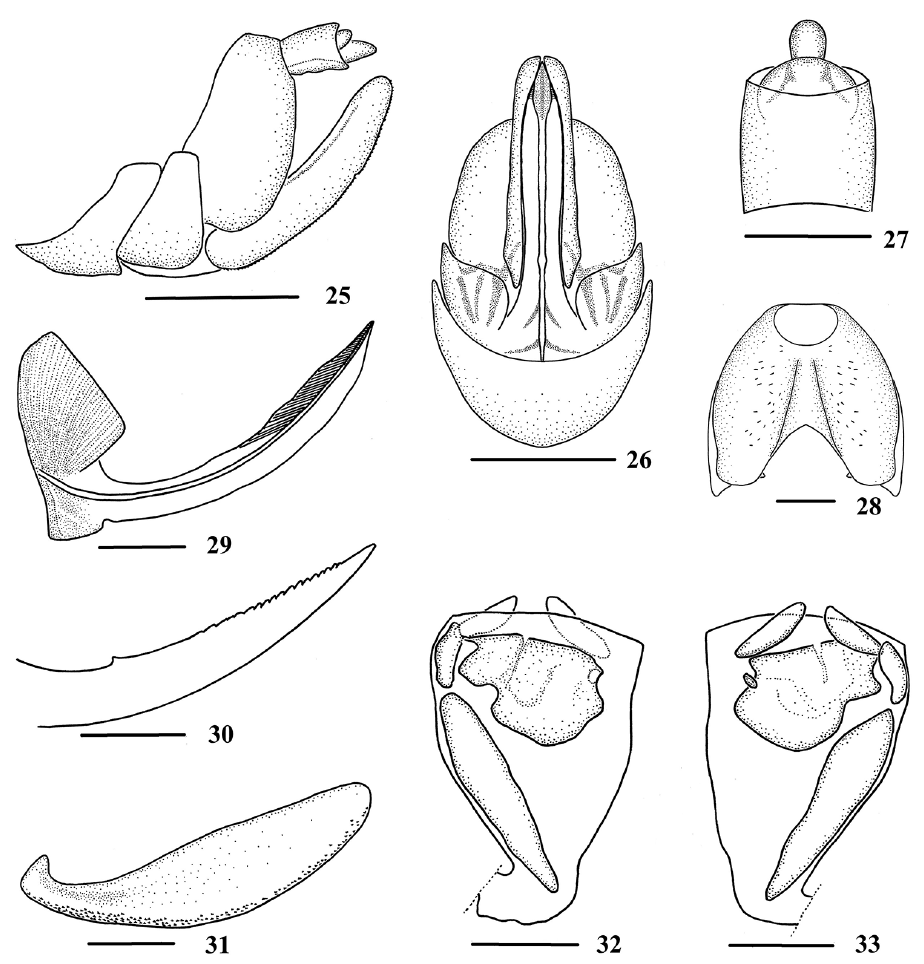
Figures 25–33. Neocarpia bidentata Zhang & Chen, 2013, female 25 Genitalia, lateral view 26 Geni- talia, ventral view 27 Anal segment, dorsal view 28 Pygofer, caudal view 29 Gonapophysis VIII and gonocoxa VIII, dorsal view 30 Gonapophysis IX, lateral view 31 Gonoplac, inner lateral view 32 Poste- rior vagina, ventral view 33 Posterior vagina, dorsal view. Scale bars: 0.5 mm ( 25–26 ); 0.2 mm ( 27–33 ). Remarks. Female of N. hamata is similar to N. acutata sp. n., but differs in: